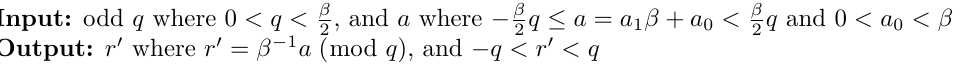
Algorithm 7 Signed Montgomery reduction [Sei18] using Montgomery factor β = 2 16 .